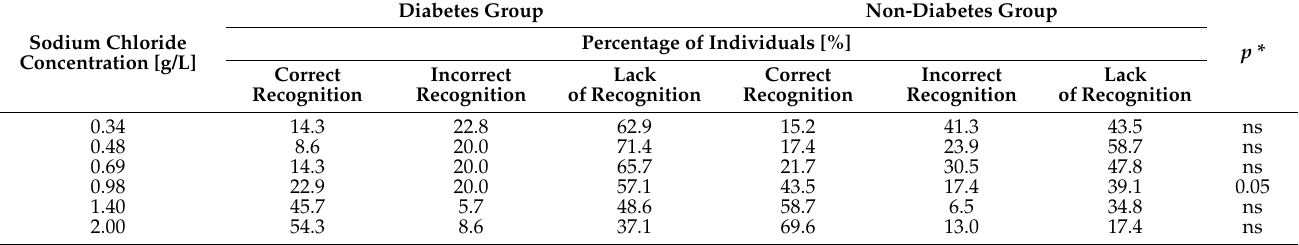
Table 5. Evaluation of the recognition of the taste of sodium chloride solutions.